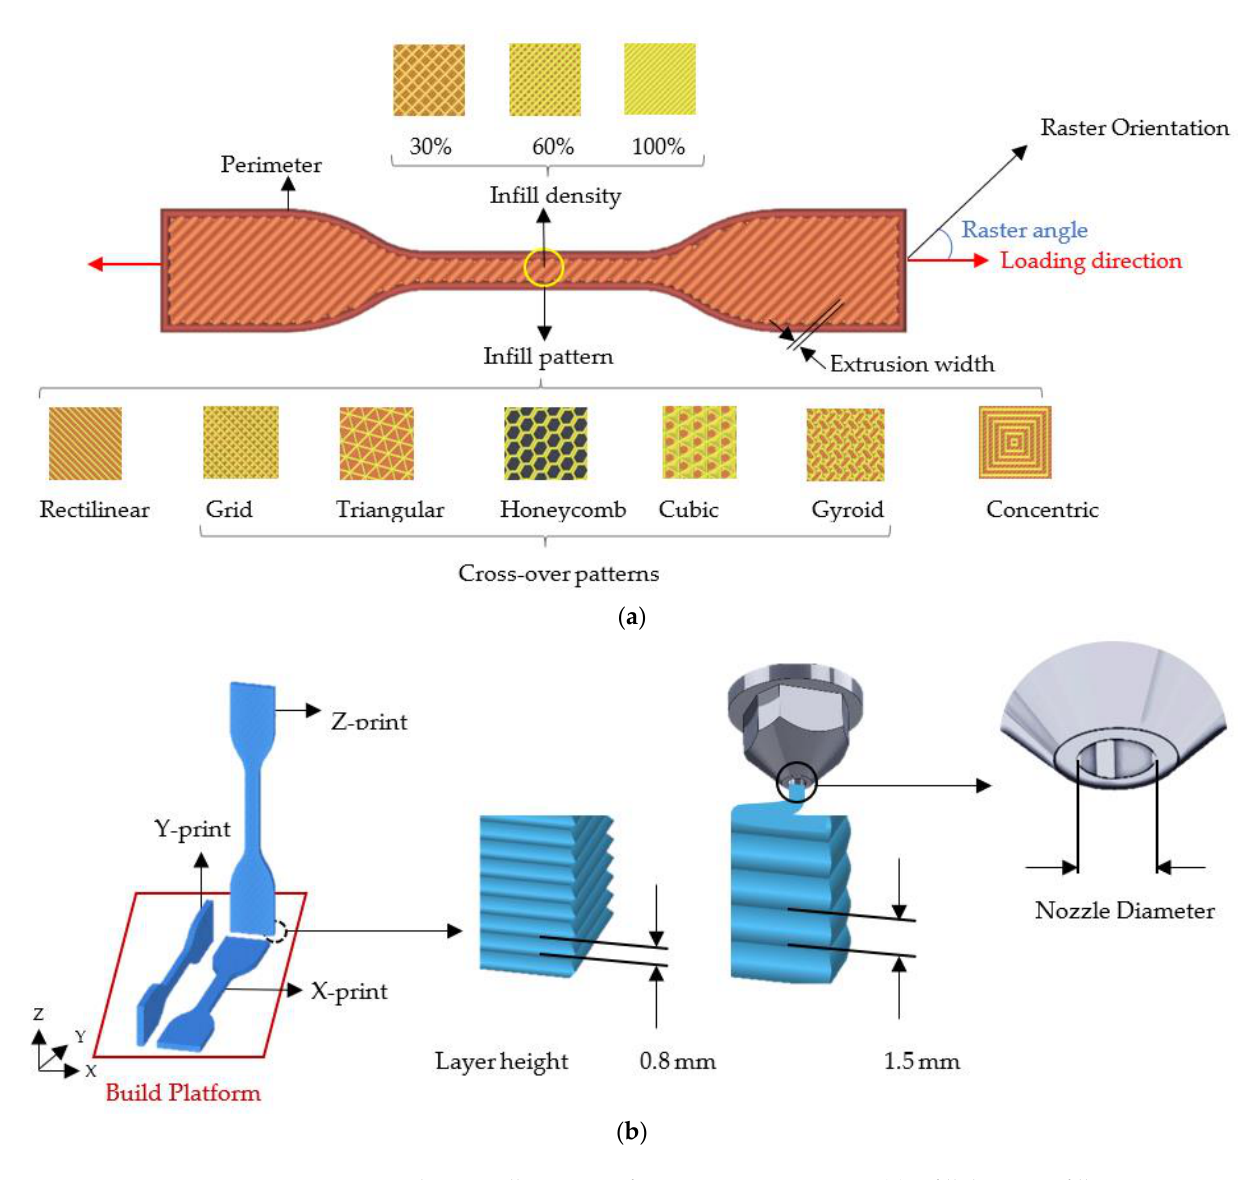
Figure 4. Schematic illustration of 3D printing parameters: ( a ) infill density, infill pattern, perime- ters, and raster orientation, and ( b ) different build orientations, layer height, and nozzle diameter. Raster orientation denotes the direction of extruded filaments in the build platform.